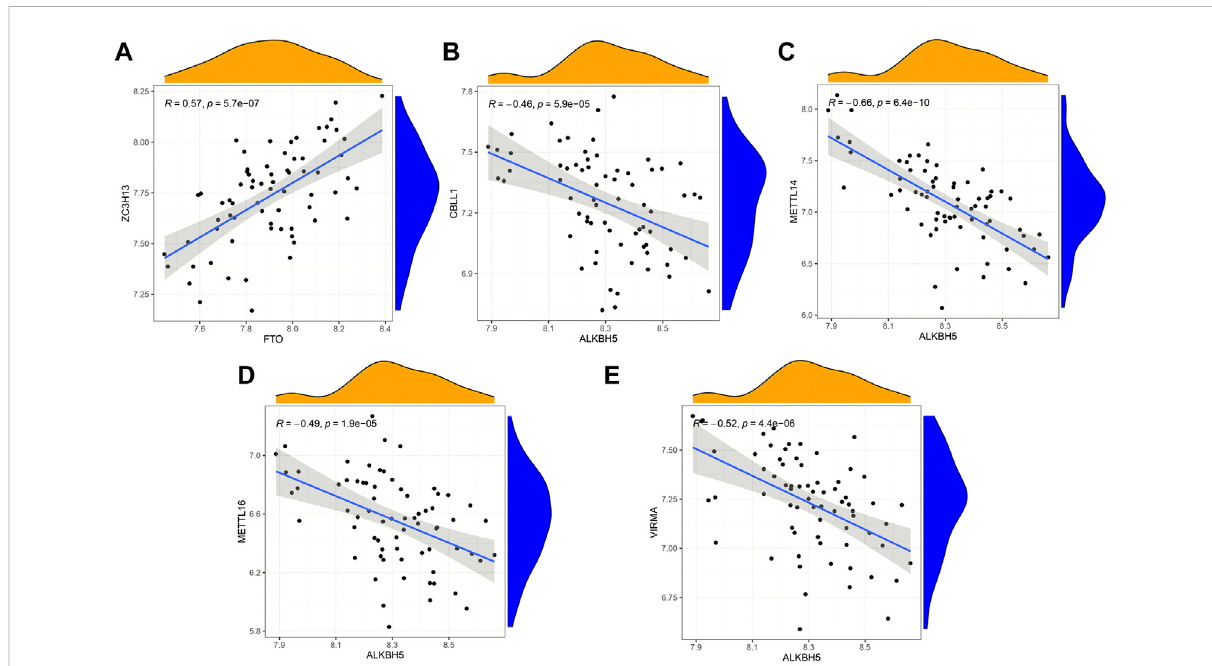
FIGURE 3 Correlation between writers and erasers in IPF (A – E) Writer genes: CBLL1, METTL14, METTL16, VIRMA and ZC3H13; eraser genes: ALKBH5 and FTO.